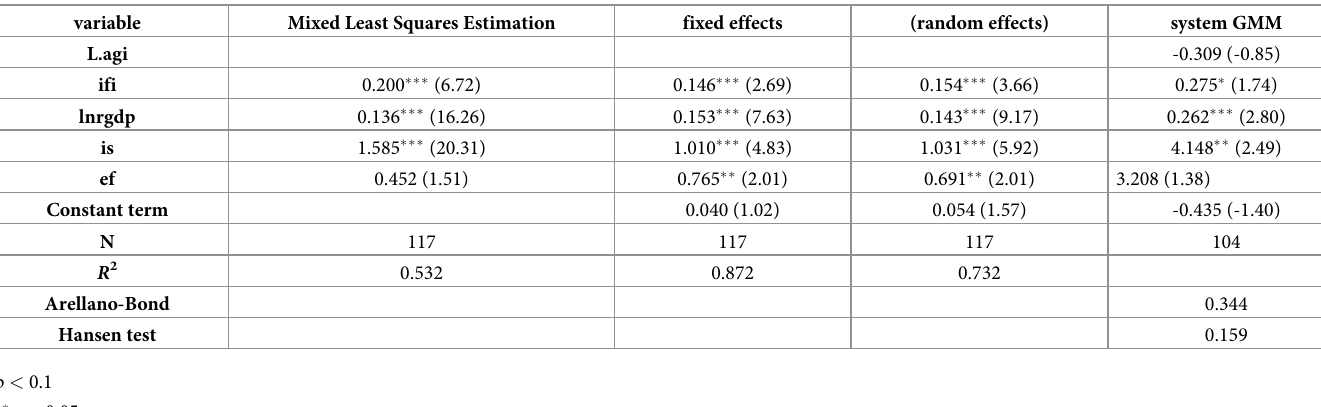
Table 6. Regression results of the impact of inclusive finance on agricultural green development in 13 provinces in China’s main grain producing areas.